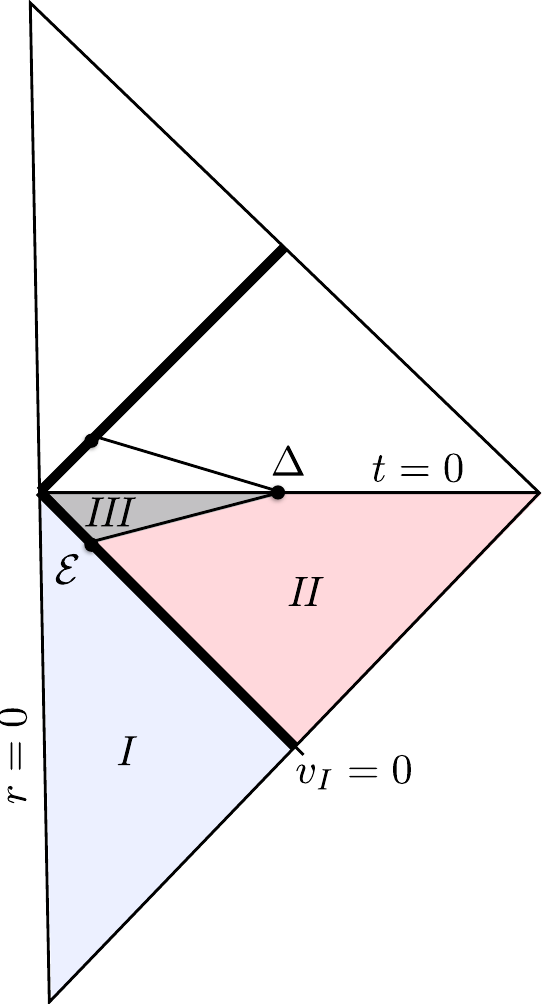
Figure 6. Causal diagram for a bouncing black hole, from [69]. (I) is flat; (II) is Schwarzschild; and (III) is the “quantum gravity”